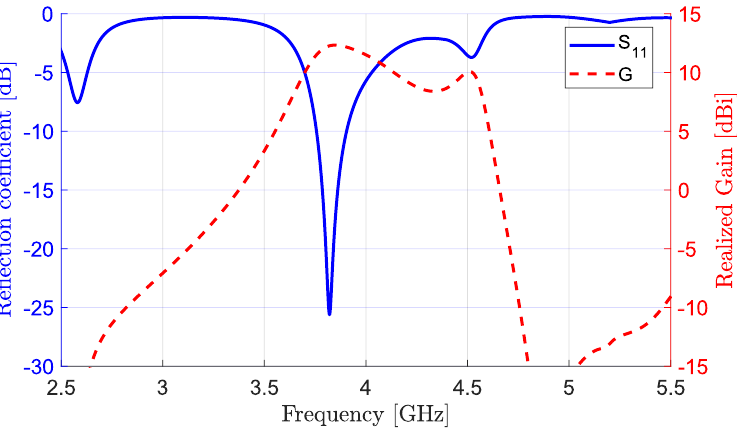
Figure 5. Simulated S 11 and gain vs. frequency of the proposed two-element standing-wave DRA array.